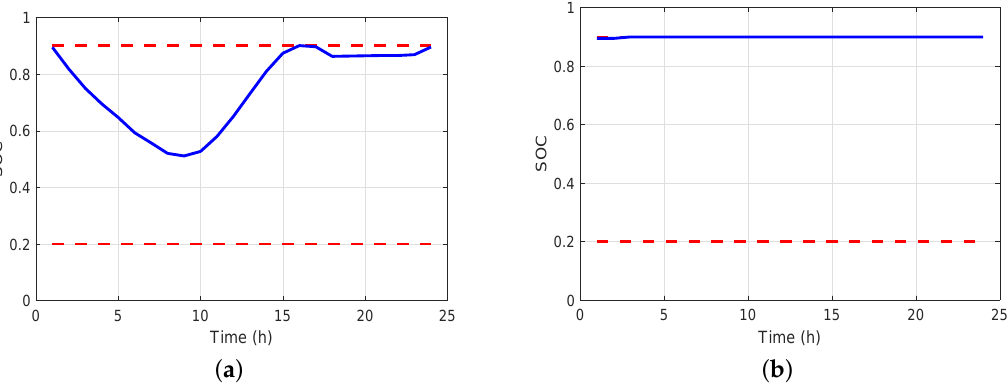
Figure 10. Power plan of studied hybrid system in simulation 3 ( a ) the DP approach; ( b ) the rule-based method.